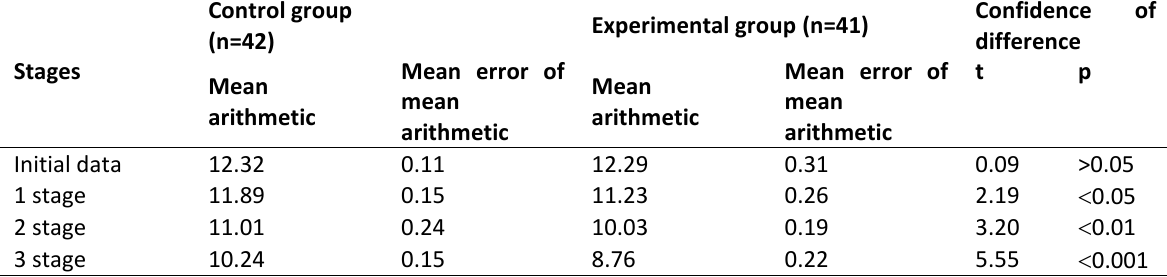
Table 2. Dynamic of Ruffiet-Dixon’s test results in experimental and control group cadets in the course of experiment, bpm